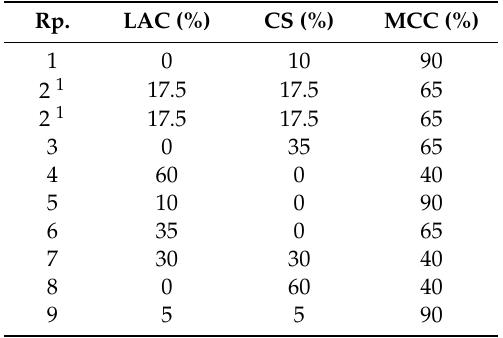
Table 2. Excipient composition of model tablets according to an extreme vertices design. Rp. LAC (%) CS (%) MCC